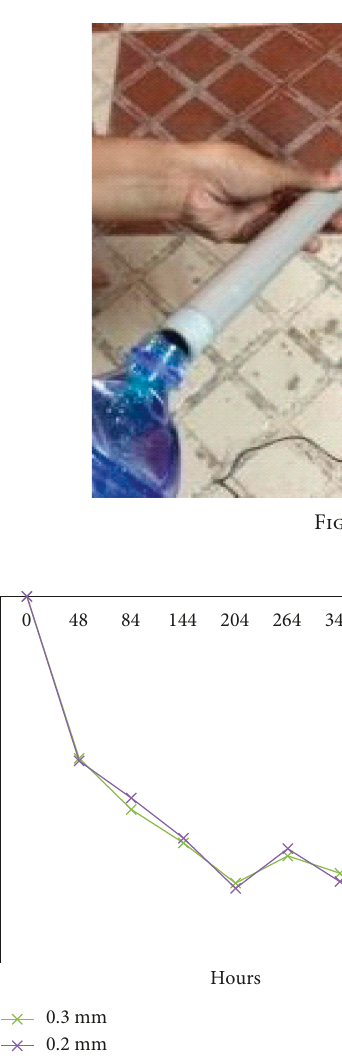
Figure 7: Potential values for conventional U-shaped beam (OPC). Figure 8: Potential values for conventional U-shaped beam